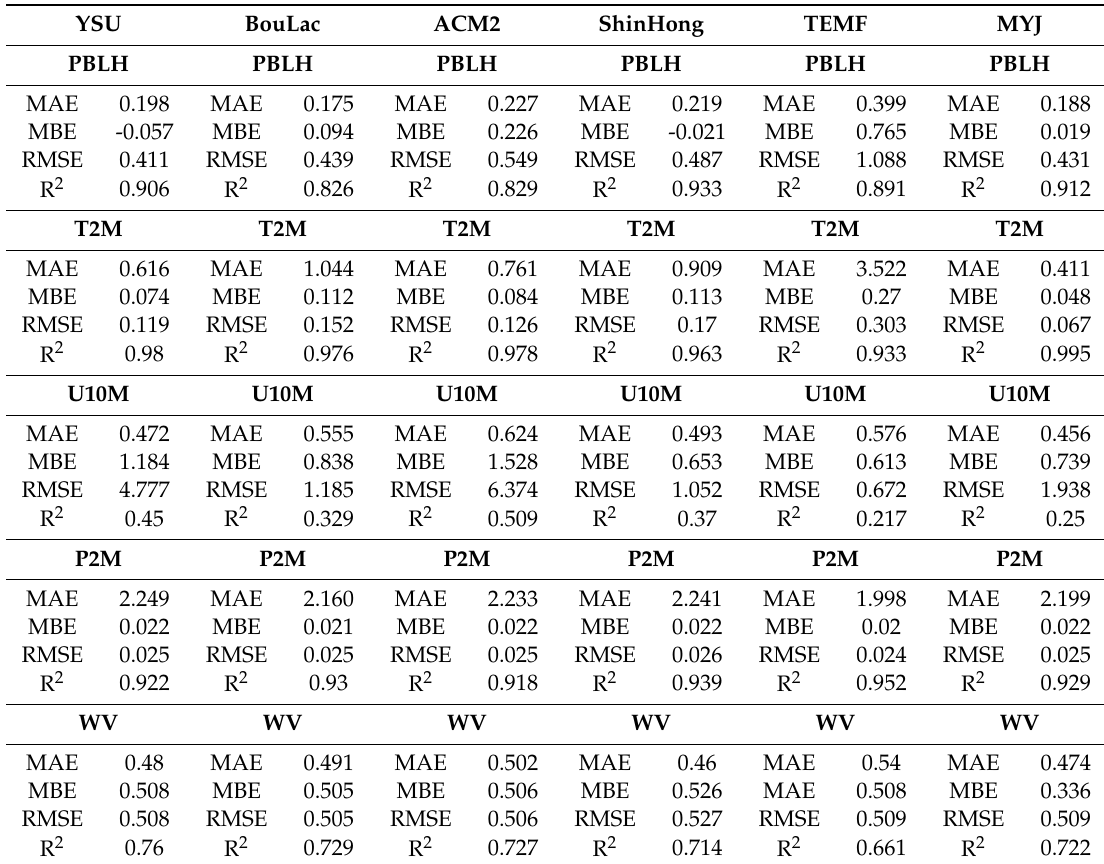
Table 2. Statistics of simulated PBLH, T2M, U10M, P2M and WV data compared to instrument-retrieved PBLH, T2M, U10M, P2M and WV data, 04 / 04 / 2016; performance indicators are MAE, MBE, RMSE, and R 2